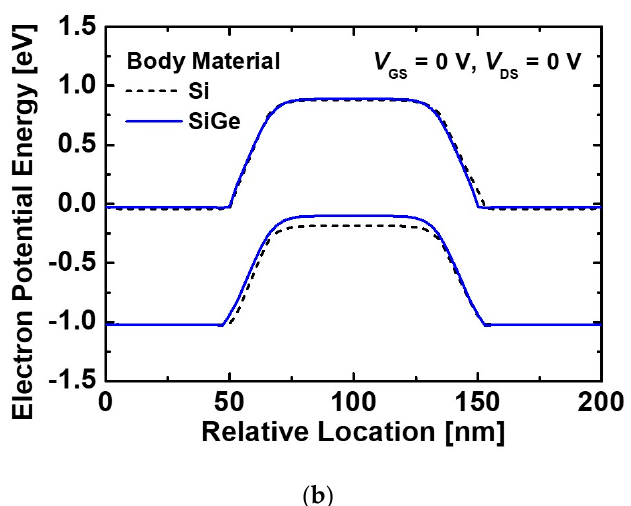
Figure 1. ( a ) 3D schematic and cross-section of the GAA-JLFET-based 1T-DRAM. ( b ) Energy band diagrams under the gate dielectric of the GAA-JLFET-based 1T-DRAMs with different body materials at V GS of 0 V and V DS of 0 V.